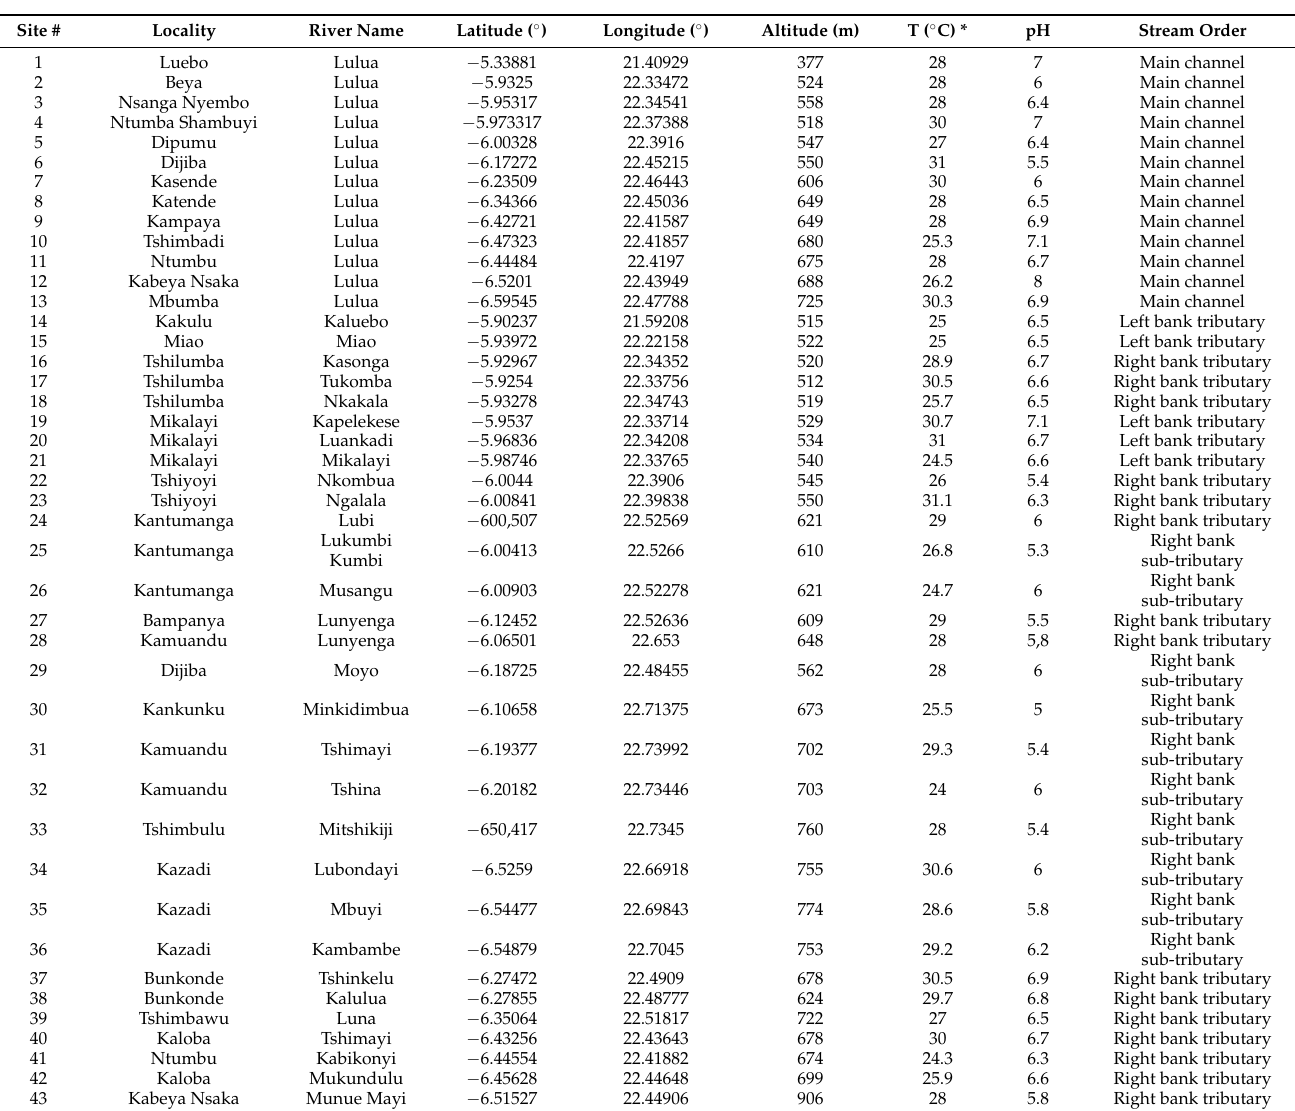
Table A1. Sampling sites: geographic and physicochemical data (* surface temperature). Geographic coordinates are given in decimal degrees with negative latitudes indicating south and positive longitudes indicating